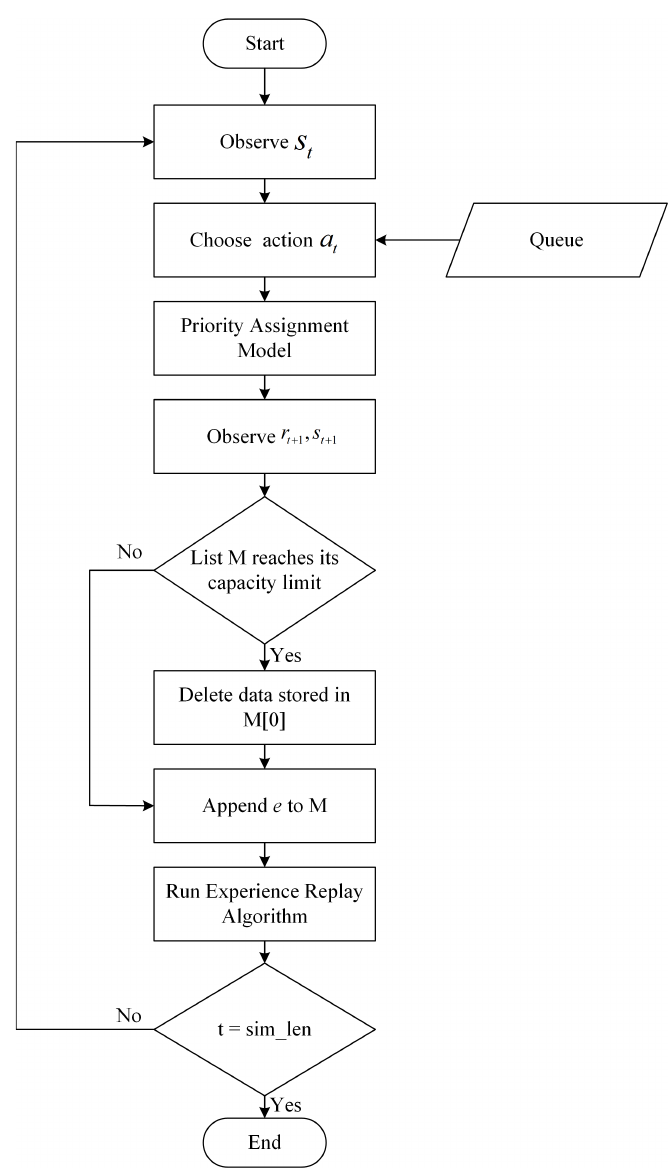
Figure 6. Flow of intersection control